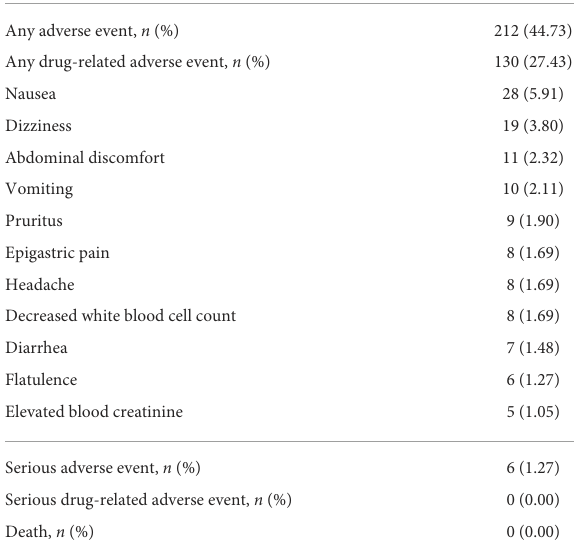
TABLE 6 Occurrences of adverse events, including the most common drug-related adverse events ( > 1%). Occurrences of adverse events ( N =